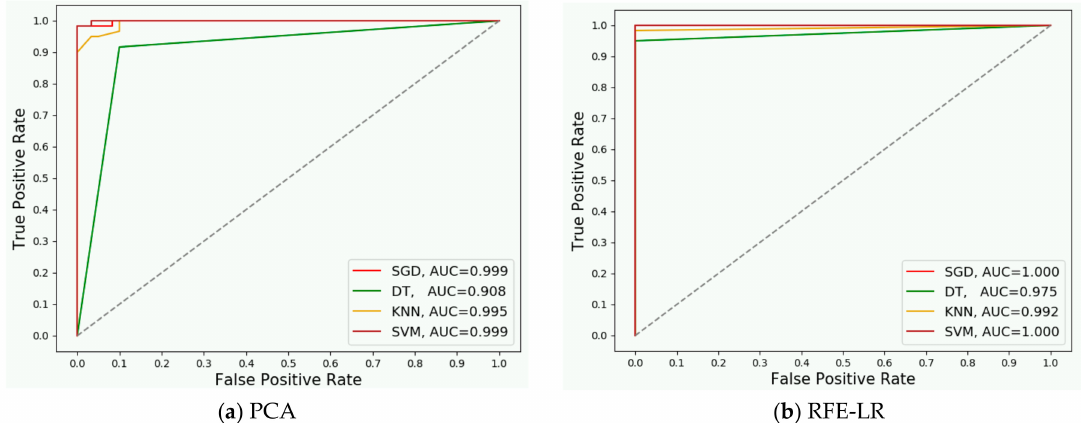
Figure 8. The ROC curve of human detection in Scenario StRmP1.